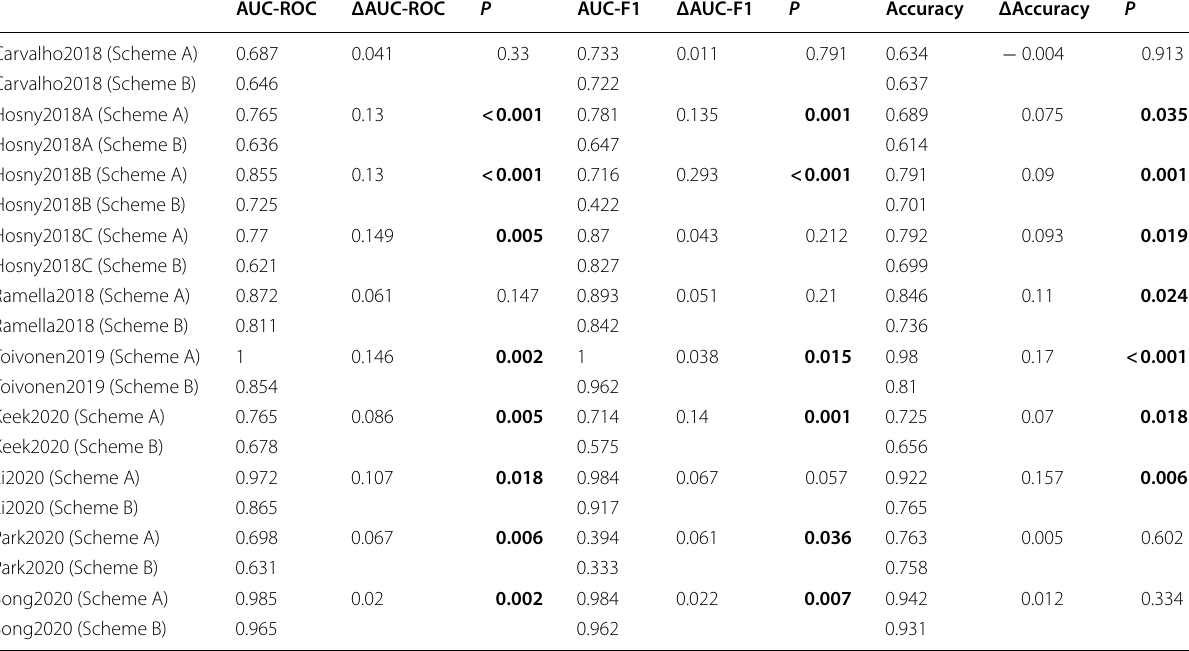
AUC-ROC, AUC-F1 and accuracy of the correct and incorrect models for each dataset as well as their differences and significance. The p -values were computed using a bootstrap test with the null hypothesis that the difference is zero. Significant p -values are marked in